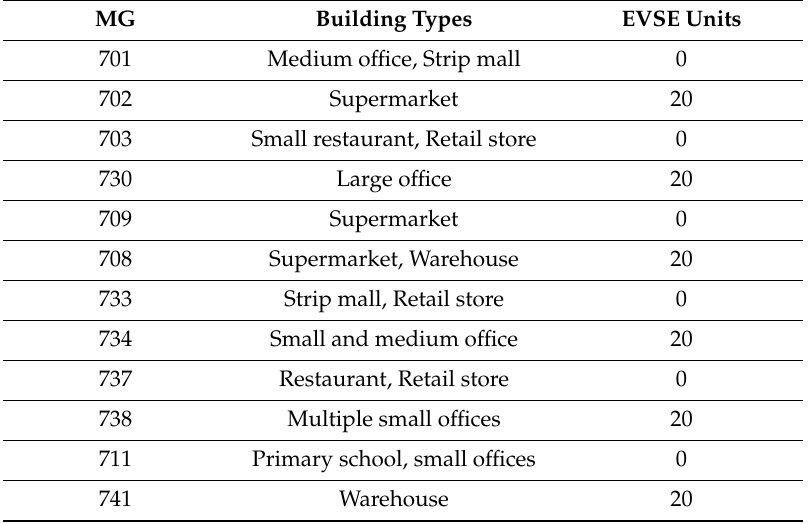
Table 1. The building and number of EVSEs in microgrids.